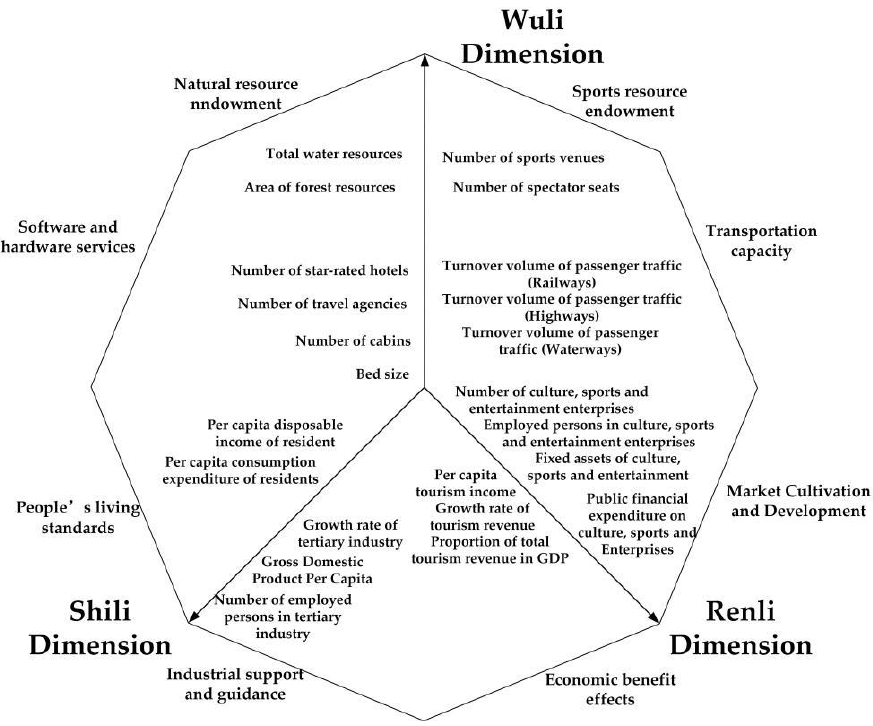
Figure 1. Impact analysis framework of the spatial distribution of sports tourism resources in